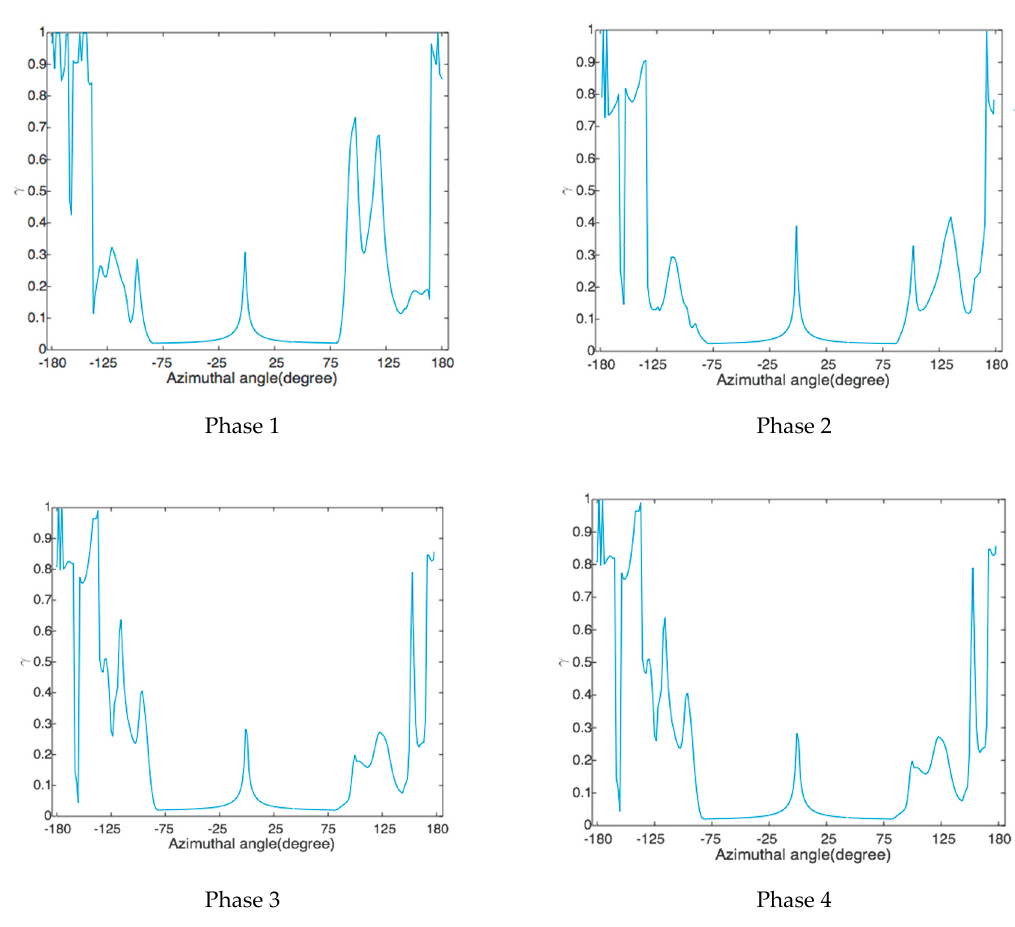
Figure 8. Langtry-Menter (LM) turbulence intermittency field ( γ ) on circular cylinder over one shedding cycle .